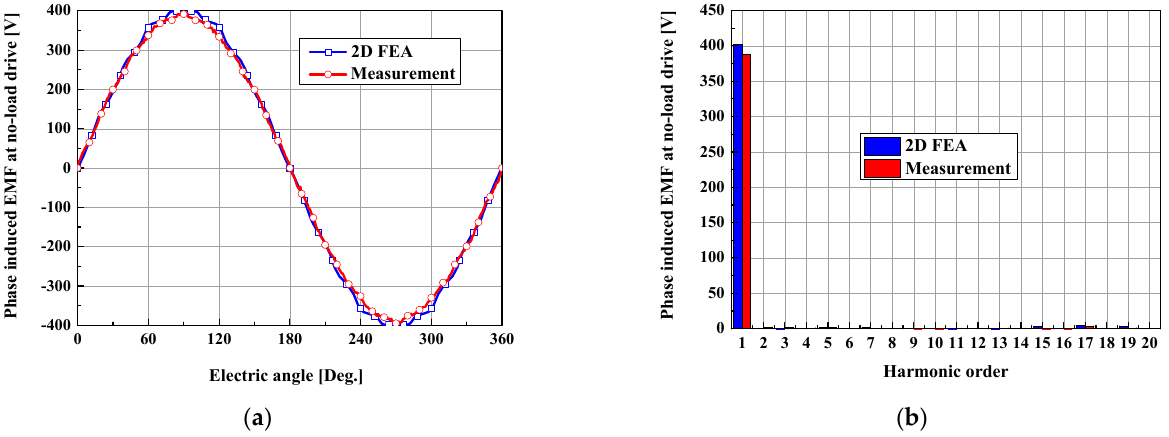
Figure 20. Measured wave form of the induced EMF at no-load drive.